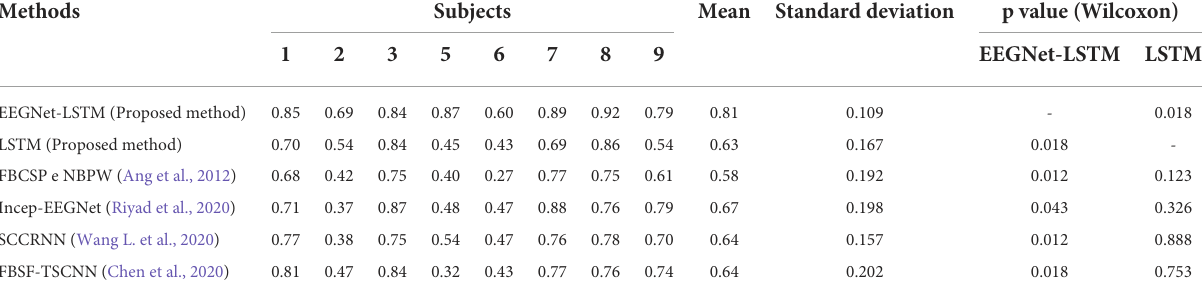
TABLE 7 Comparison with the kappa values achieved by other